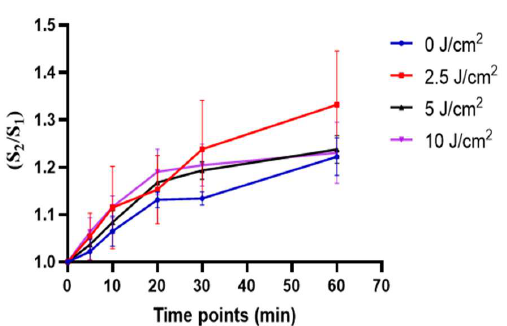
Figure 4. A plot of time-lapse Rh123 of mitochondrial membrane potential in PBM. Values demon- strated the ratio of mean intensity before and after 0, 10, 20, 30, 60 min PBM ( n = 3). Statistical anal- ysis (one-way ANOVA) for significant differences between after 30 PBM and other time points ob- served at all fluences, including 0, 2.5, 5, and 10 J/cm 2 ( p ≤